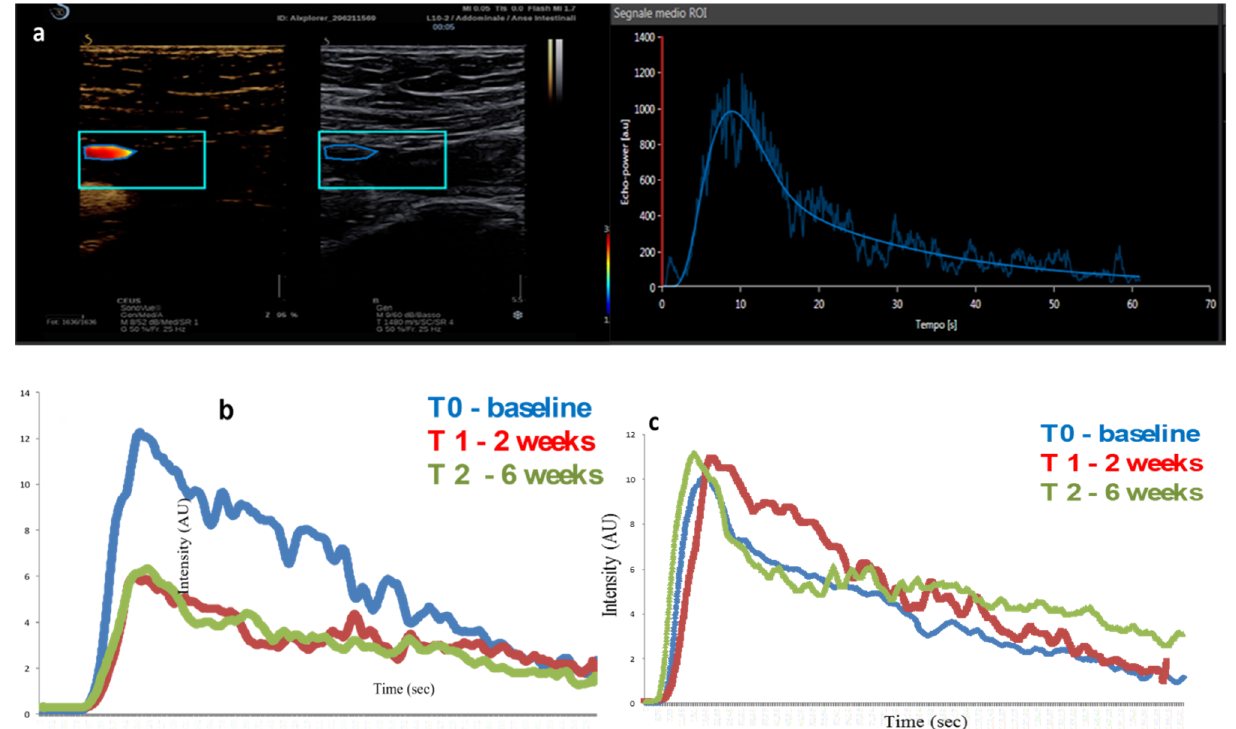
Figure 2. Contrast-enhanced ultrasound (CEUS) with the corresponding time–intensity curve in two patients with ileal Crohn’s disease under biological treatment. Baseline evaluation ( a ). Time–intensity curves of bowel wall enhancement at different time points showing lower enhancement and lower area under the enhancement curve after treatment in responder ( b ) and no significant difference in perfusion parameters in non-responder ( c ). Baseline = blue curve, week 2 = red curve, week 6 =green curve, AU = Arbitrary